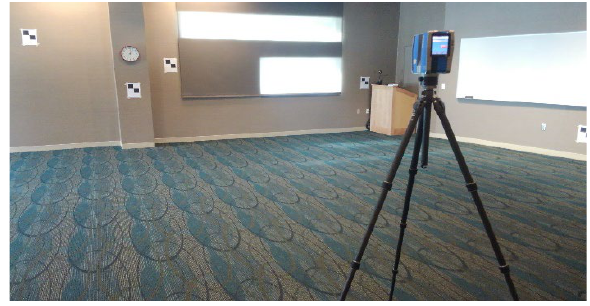
Figure 2. Test field scanning by FARO Scanner After the scans orientation in one model, the total size of the model was equal over 40 million points (Fig. 3).